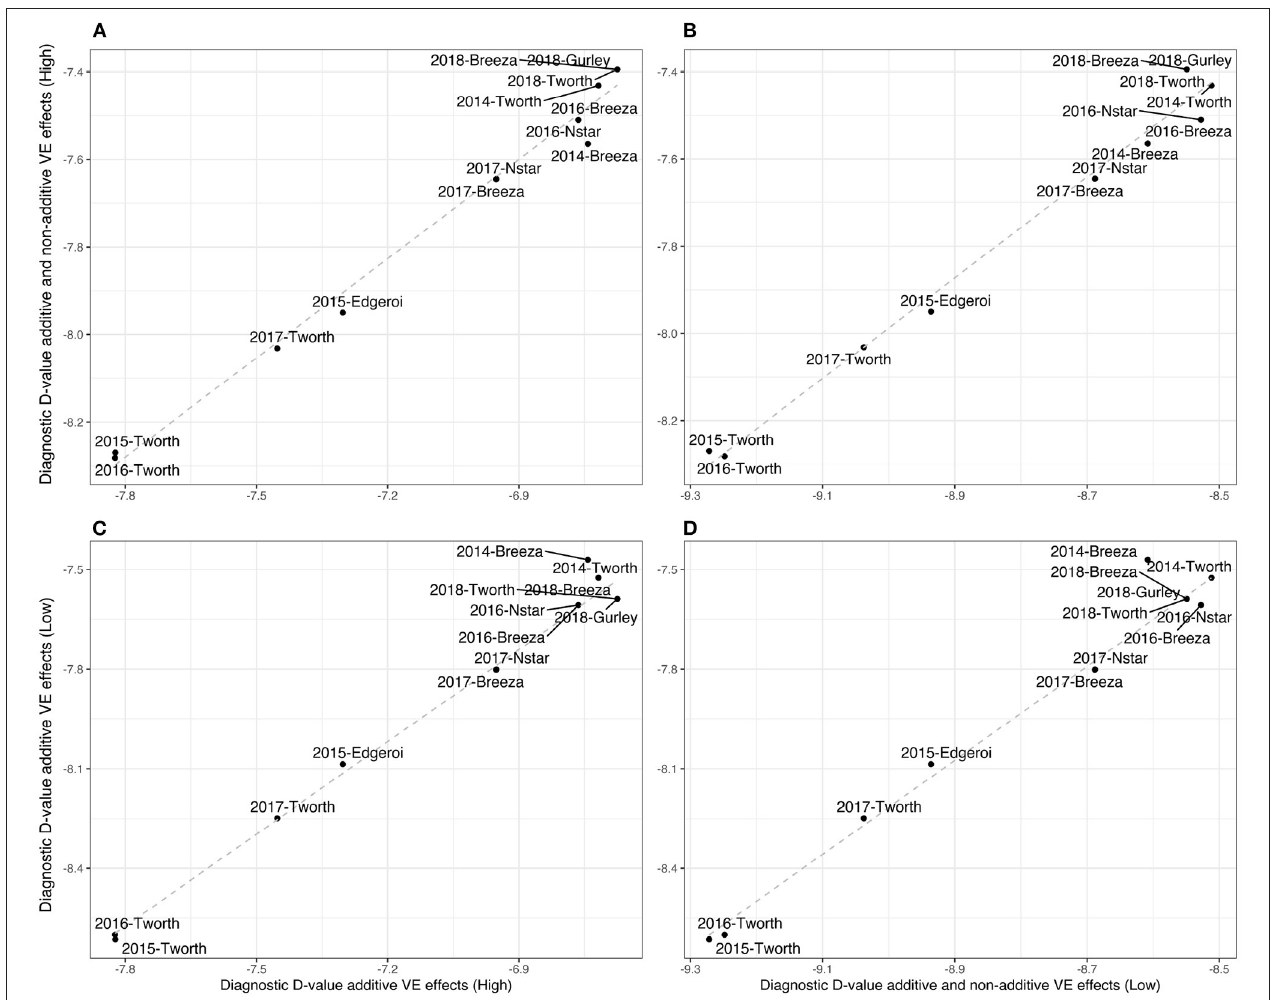
FIGURE 2 | Durum example: Comparisons of Diagnostic D j -values based on LMMs with additive and non-additive VE effects [ D j (A+I)] and those based on LMMs with additive VE effects alone ( D j (A+I)) for high and low parameter values of additive variance (80 and 40%, respectively) and between environments genetic correlation (0.8 and 0.4, respectively). (A) D j (A+I) against D j (A) values using the high parameter values, (B) D j (A+I) against D j (A+I) values using high and low parameter values, respectively, (C) D j (A) against D j (A) using high and low parameter values, respectively, and (D) D j (A) against D j (A+I) using low parameter